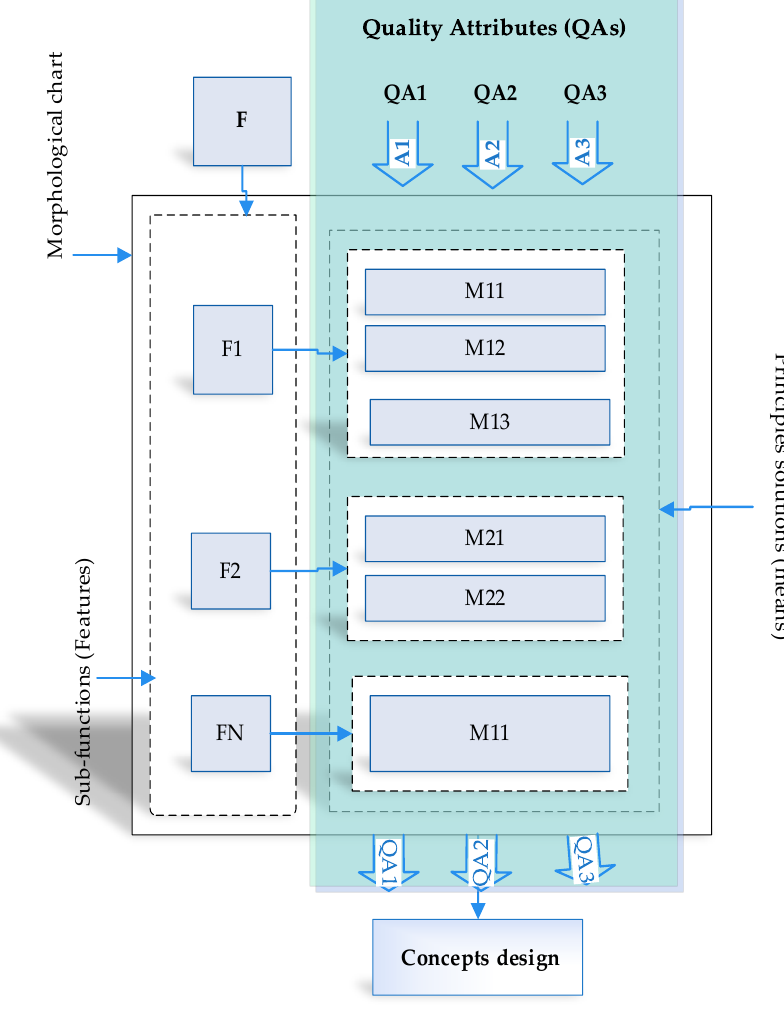
Figure 1. Product conceptual design morphological chart and QAs.